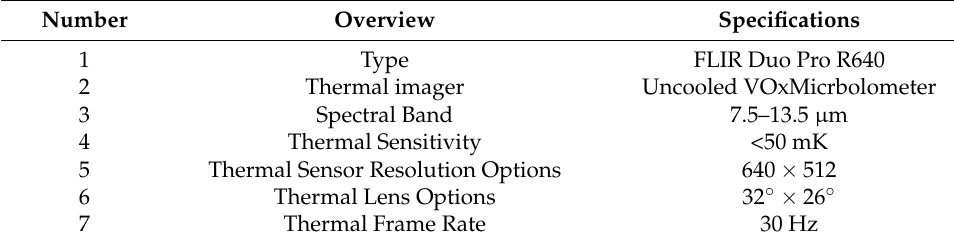
Table 1. Parameters of the infrared camera used in the